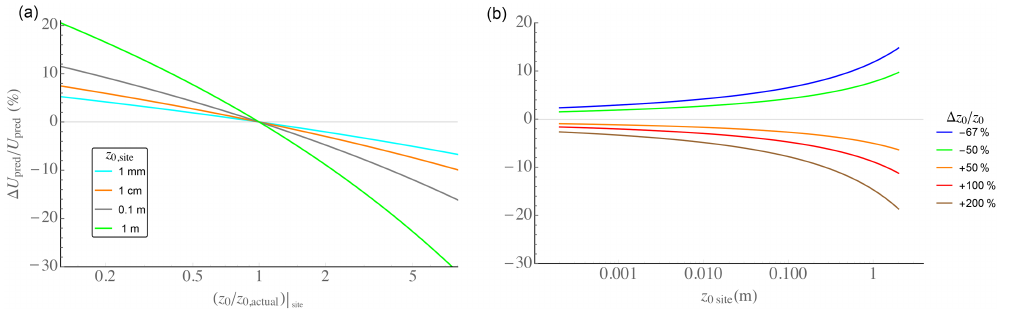
Figure 4. Error in predicted wind speed due to error in background roughness at prediction site via Eq. (10), for observation height z obs = 60m and prediction (hub) height of z pred = 100m. (a) Error vs. ratio ( = a ) of estimated to actual background z 0 . (b) Error vs. background z 0 at observation mast; uncertainties of {− 67 , − 50 , 50 , 100 , 200 } correspond to a =